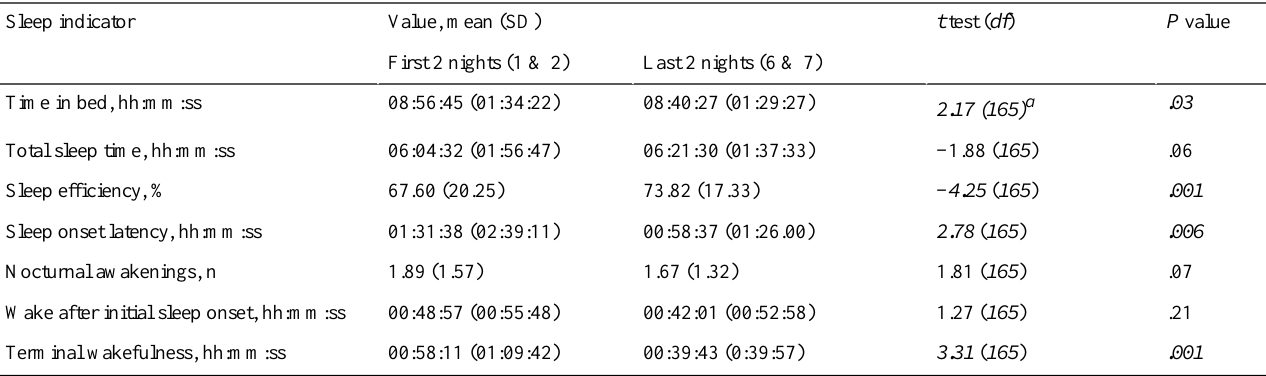
Table 3. Nocturnal sleep indicators of users completing Step 1